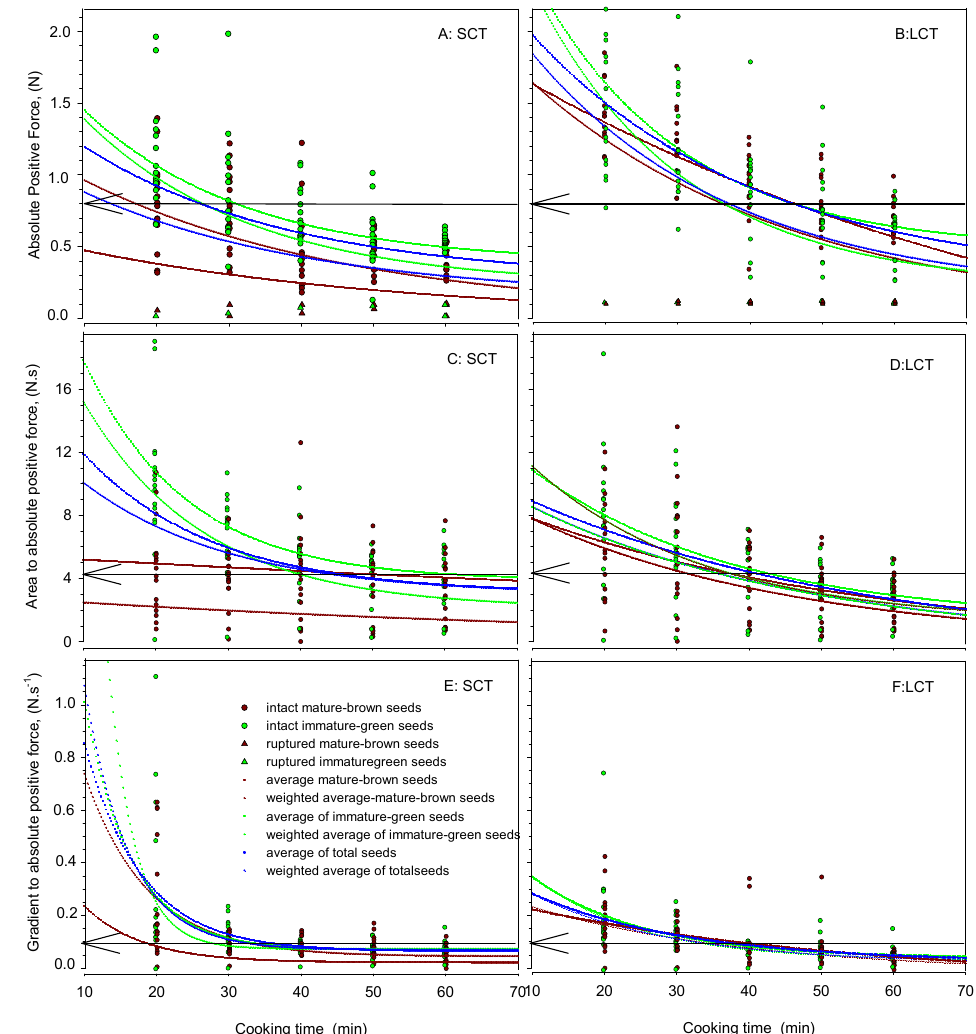
Figure 3. Distribution of APF (absolute positive force, ( A , B )), AAPF (area to absolute positive force, ( C , D )), and GAPF (gradient to absolute positive force, ( E , F )) values of MB, IMG, and total lentil seed samples, of either easy (SCT) or hard (LCT) to cook lentil seeds, under cooking at 100 ◦ C for 20–60 min. Each sample consisted of ~300 seeds per cooking time, of which 30 seeds (15 MB and 15 IMG) were subjected to texture analysis. Solid lines represent curve fitting according to the exponential decay model. The arrow indicates the threshold of optimum cooking obtained from Figure 2.